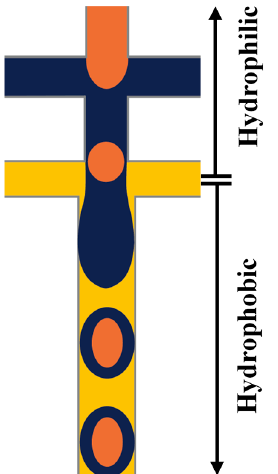
Figure 8. A poly(dimethylsiloxane) (PDMS) device with two serial cross junctions for formation of O/W/O double emulsion using two consecutive emulsification steps. The dripping instabilities are present in both junctions; the inner phase is emulsified at the first junction followed by the middle phase at the second junction [109].